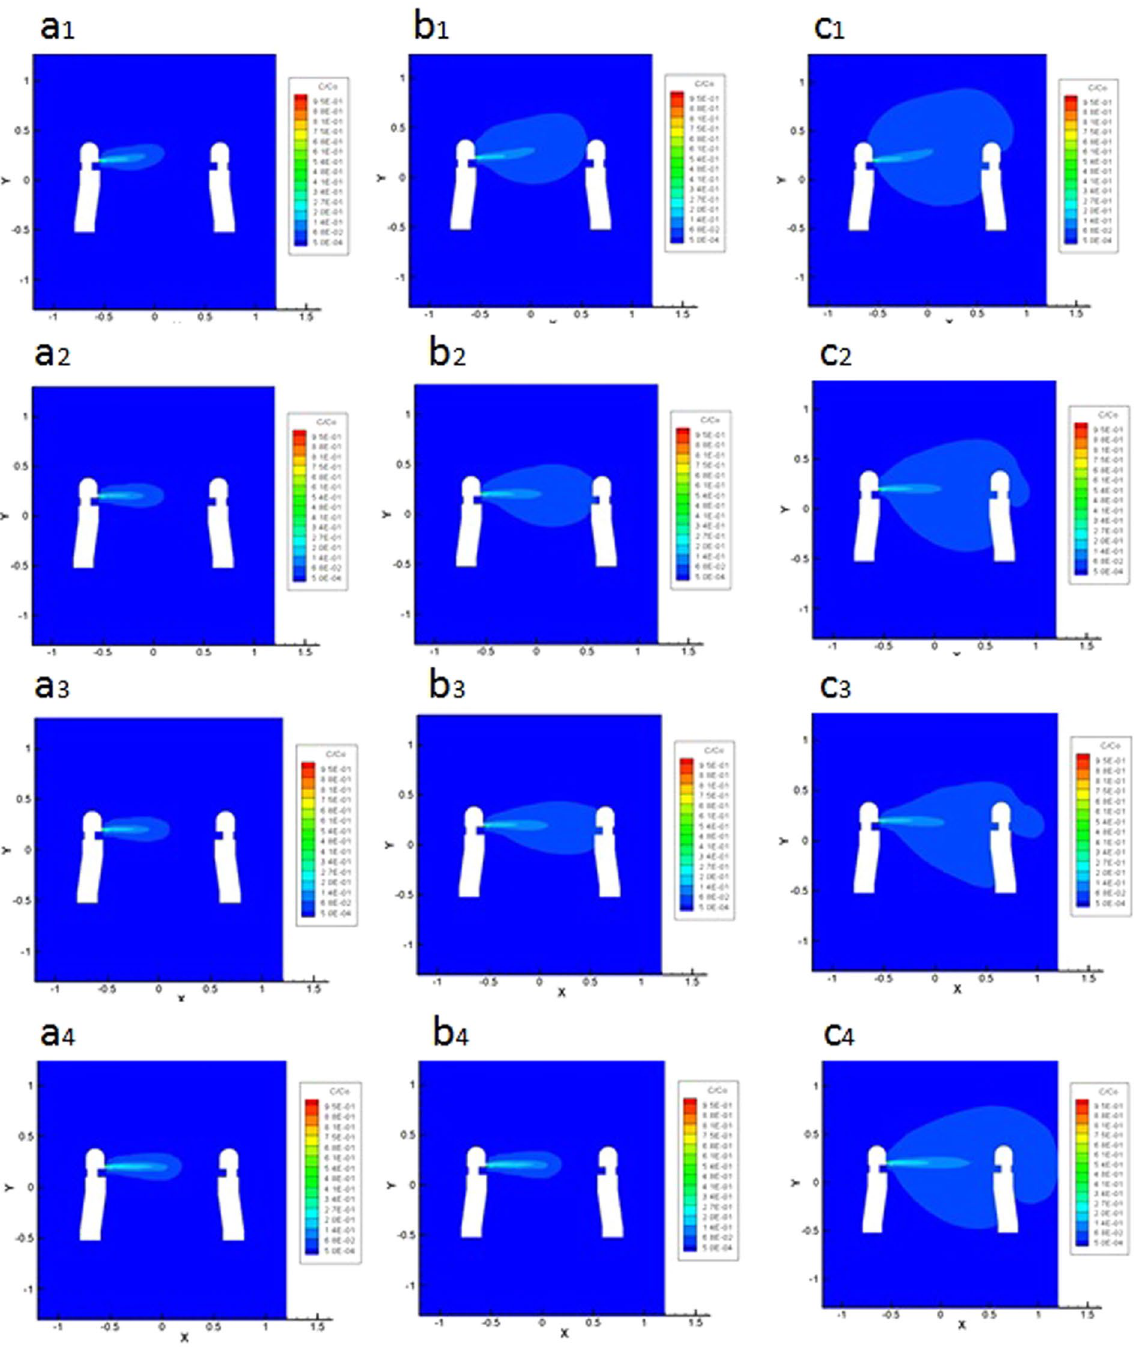
Figure 3. The cloud image of mass concentration distribution of CO 2 under unstable case (case 1), neutral case (case 2), stable case (case 3) and 0 gravity case (case 4), formed on the section of z = − 0.45 m, at t = 1 s, t = 4 s, t = 10 s; a geometric model in 1:1 proportion with actual laboratory is established to ensure consistency with the experimental results. RNG k − ε viscosity model and Boussinesq approximation is adopted; four cases are related to two gravity condition: one has the acceleration of gravity of − 9.8 m/s 2 (case 1, case 2, case 3),and the other one does not consider the effect of gravity (case 4, relating to unstable of T t < T b , neutral of T t = T b , stable condition of T t > T b ); SIMPLEC method and the second order upwind difference scheme are adopted in calculating process; standard wall function is adopted; residuals of k and ε are both 10 − 3 , and the rest variables are both 10 − 6 . ( a 1 , a 2 , a 3 ) When t = 1 s, cloud images of three cases (case 1,case 2,case 3); ( b 1 , b 2 , b 3 ) when t = 4 s, cloud images of three cases (case 1,case 2,case 3); ( c 1 , c 2 , c 3 ) when t = 10 s, cloud images of three cases (case 1,case 2,case 3); ( a 4 , b 4 , c 4 ) cloud images of 0 gravity case, where G c number is